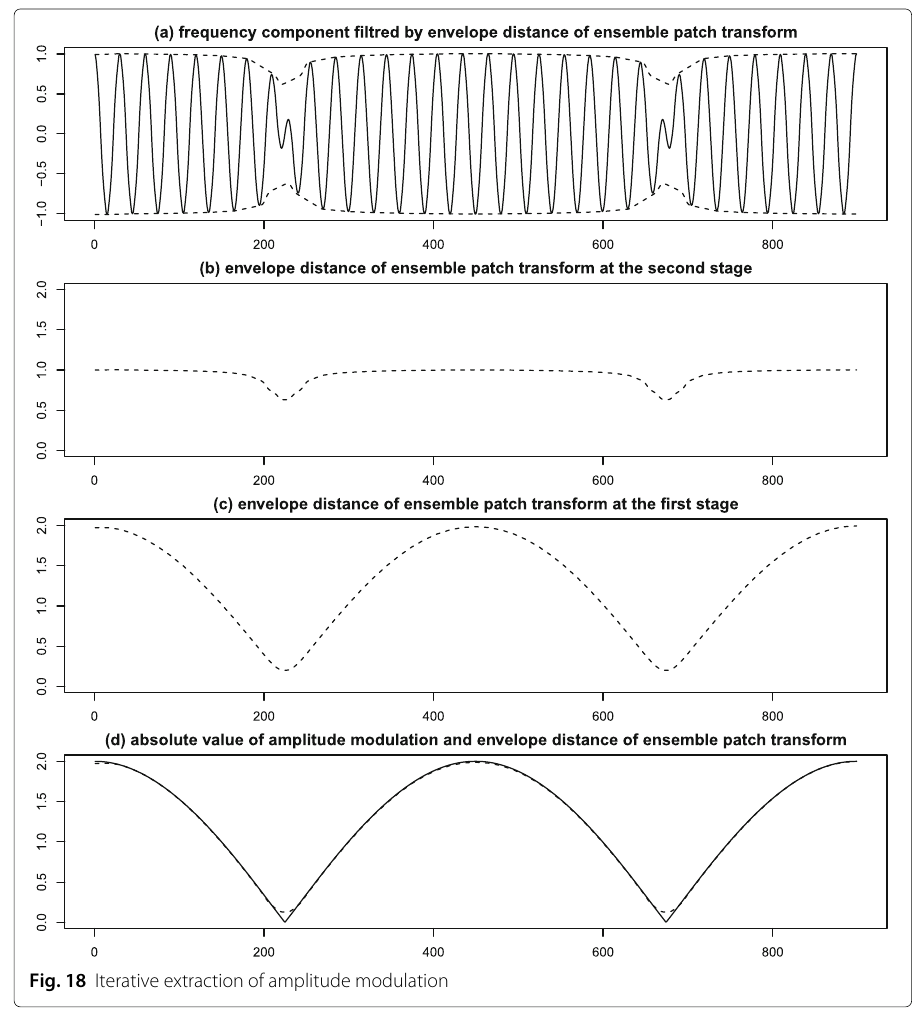
Fig. 18 Iterative extraction of amplitude